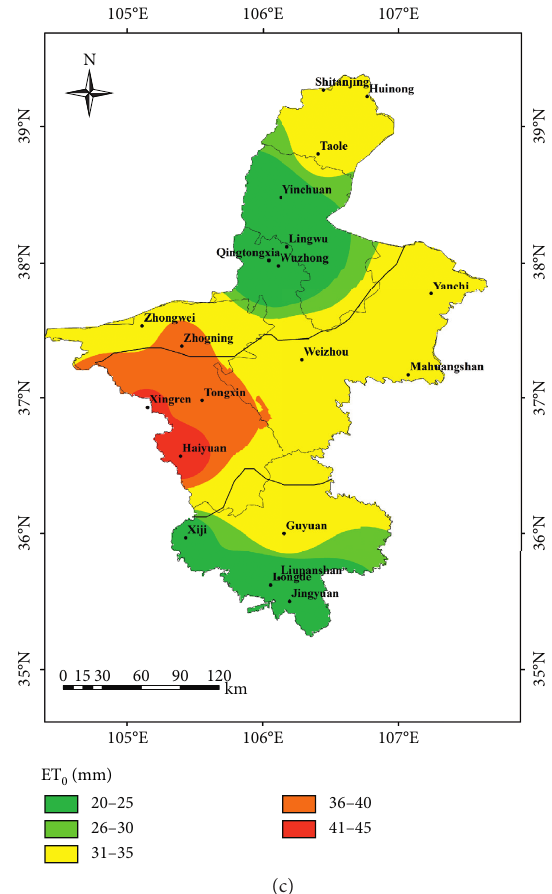
Figure 7: Spatial distribution of ET 0 at different times: (a) April; (b) August; (c)